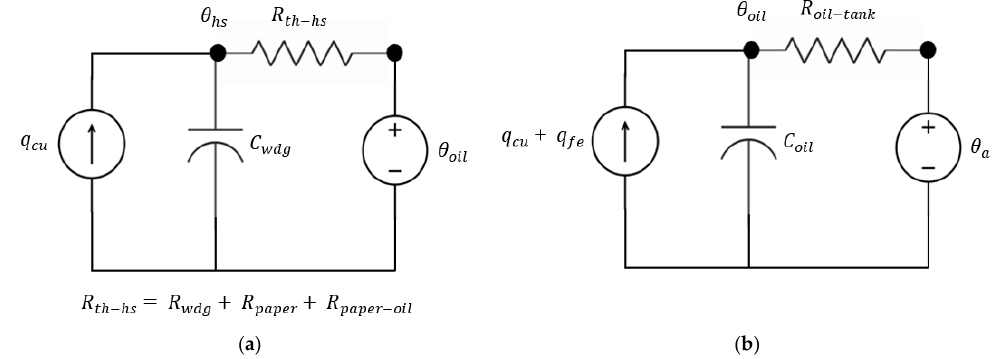
Figure 6. Thermal-electrical analogy circuit: ( a ) hot-spot temperature; and ( b ) top-oil temperature.